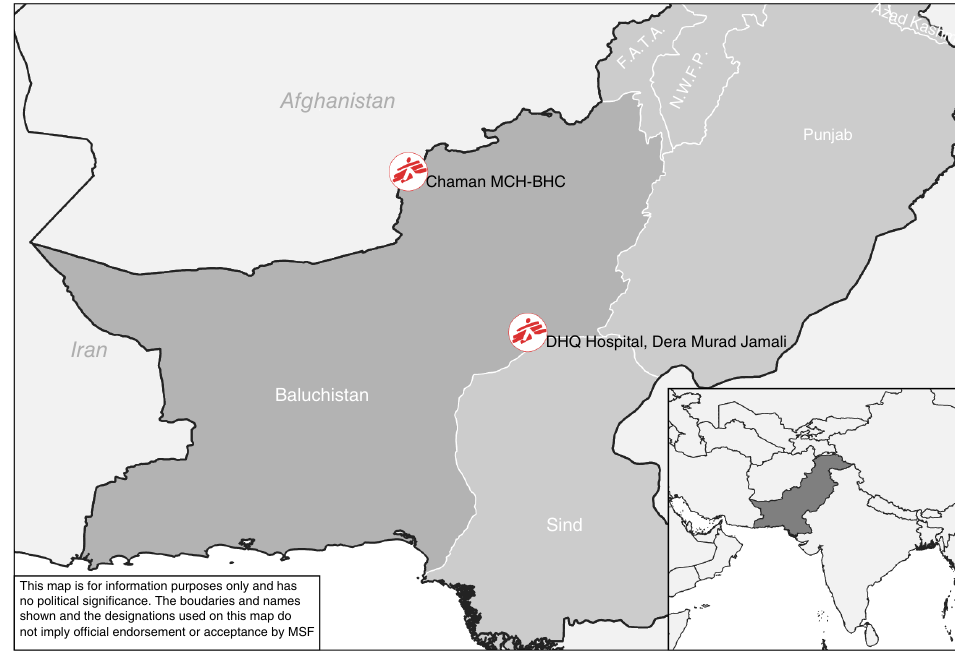
Figure 1. Projects of Médecins Sans Frontières (MSF) in Pakistan. Author: MSF UK Data Source: Natural Earth;